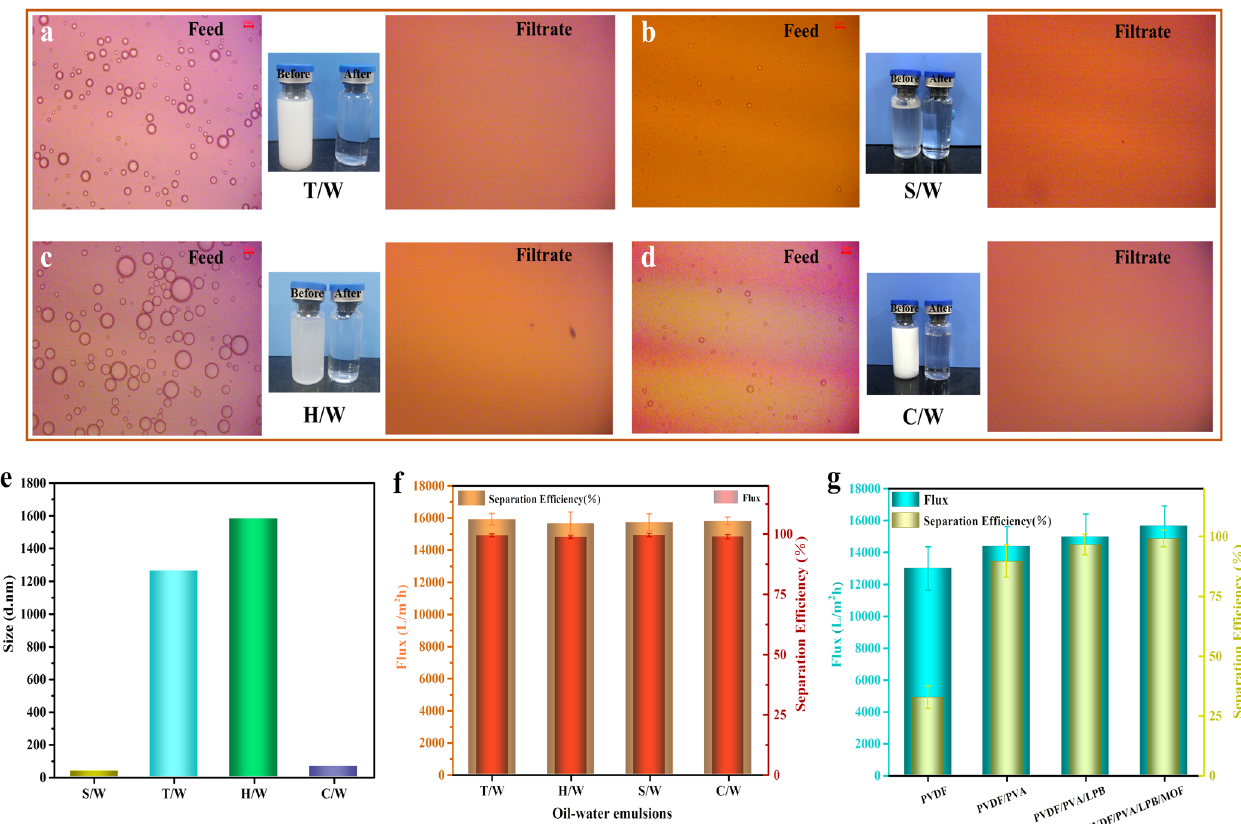
Fig. 5 Separation performance of composite membrane for different stable O/W emulsions. Photomicrographs and images of a T/W, b S/W, c H/W and d C/W emulsions before and after PVDF/PVA/LPB/MOF membrane fi ltration. e The particle size of different emulsions. f Water fl ux and separation ef fi ciency of PVDF/PVA/LPB/MOF membrane in different emulsions (s.d.). g Water fl ux and separation ef fi ciency of different mixed membranes in cyclohexane-in-water emulsion